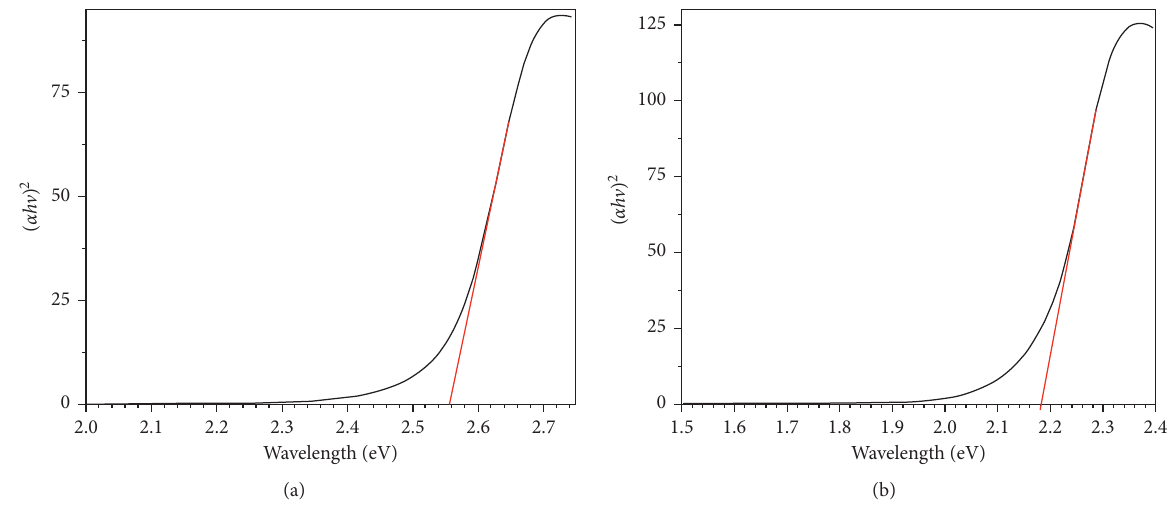
Figure 8: Tauc’s plots of HAAT (a) and Ni(II) complex (b). Table 6: The HOMO energy (E H ), LUMO energy (E L ), energy gap ( Δ E H-L ), electronegativity ( χ ), global hardness ( η ), softness ( δ ), electrophilicity ( ω ), and optical band gap ( E g ) of the ligand and metal complexes in eV.